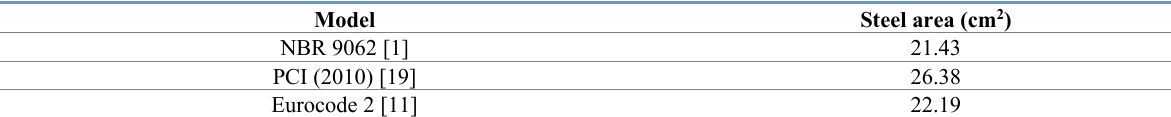
Table 9. Reinforcement areas of the main